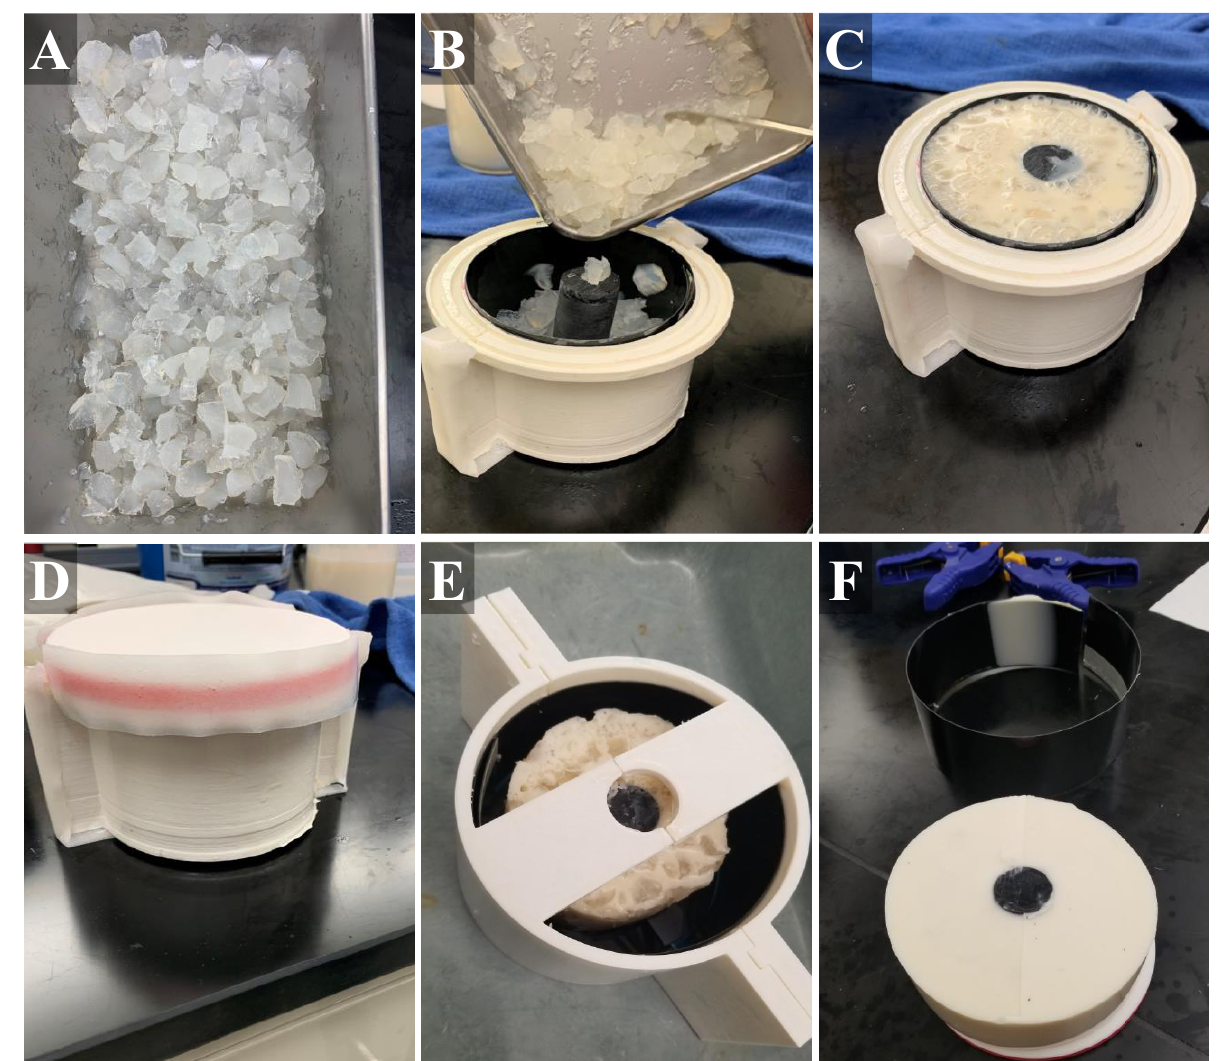
Figure 2. Stepwise construction of the gelatin phantom. ( A ) Chopped agarose fragments with different flour concentrations were first created. ( B ) Next, black plastic liner was placed into the inner mold (muscle layer) and the agarose fragments were added, as well as a plastic bone. ( C ) Then, muscle gelatin solution is poured into the inner mold. ( D ) The lid was secured with tape and the sealed mold placed on ice. ( E ) After solidification, the muscle layer was removed from the inner mold and placed in the center of the outer mold (fat layer). ( F ) After outer layer solidification, the tissue phantom (with bone, muscle layer, fat layer) was removed from the mold and used for imaging applications.